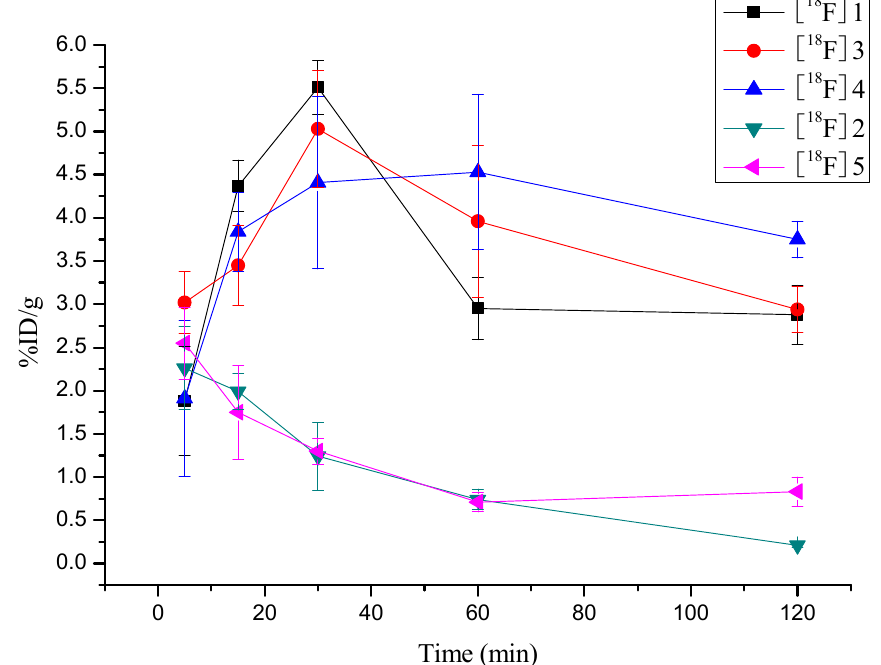
Figure 4. Comparison of tumor uptake rates of [ 18 F] 1 , [ 18 F] 3 and [ 18 F] 4 with those of [ 18 F] 2 and [ 18 F] 5 in the same animal model bearing S180